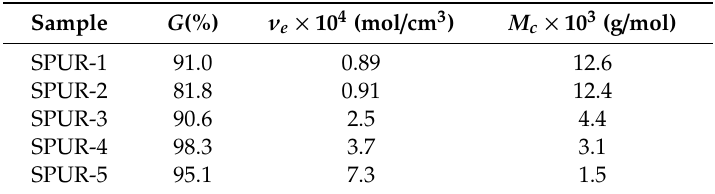
Table 3. The gel content ( G(% )), crosslink densities ( ν e ) and the average molecular weights of segment between crosslinks ( M c ) with di ff erent sucrose content determined in